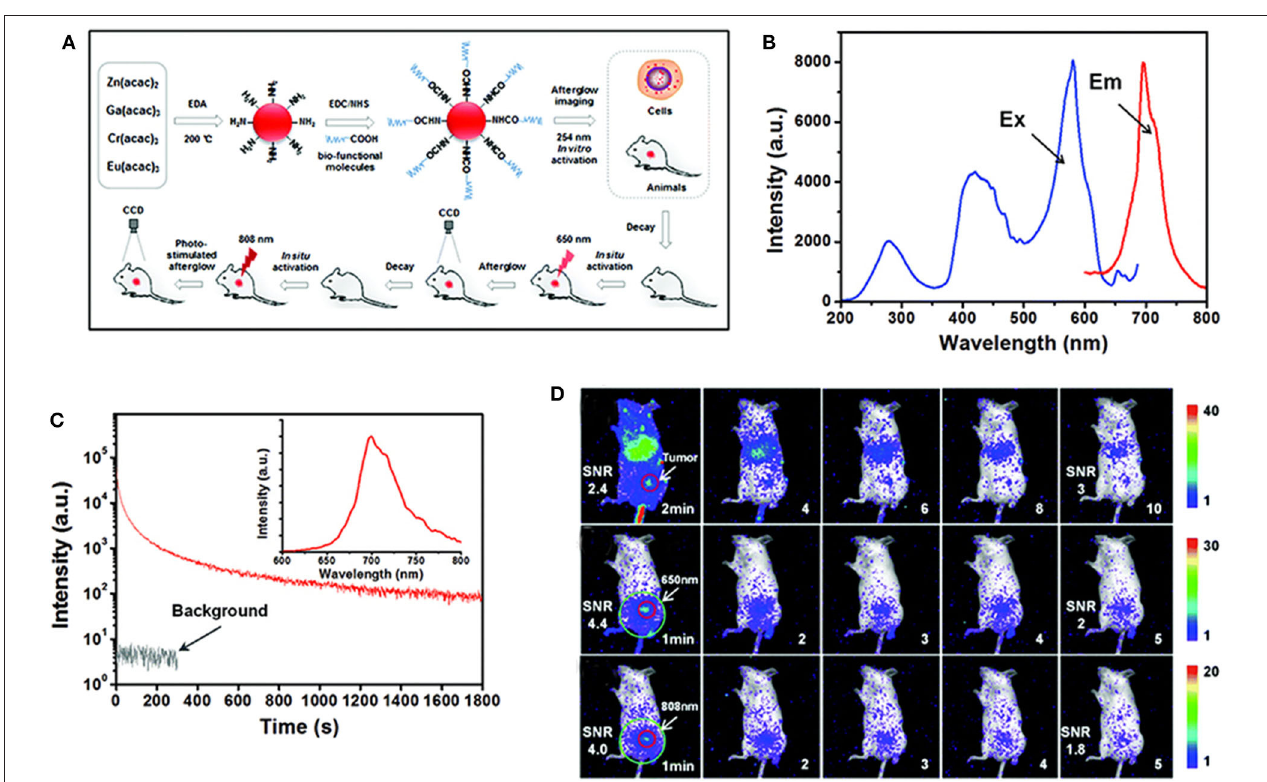
FIGURE 2 | (A) Schematic diagram of synthesis and bioimaging application of the PLPs, (B) emission and excitation spectra of the PLPs, (C) decay curve of the PLPs of excitation at 254nm and the inset is PersL spectrum, (D) bioimaging in mice after injection of PLPs. Reproduced from a literature Shi et al. (2016) with permission from Royal Society of